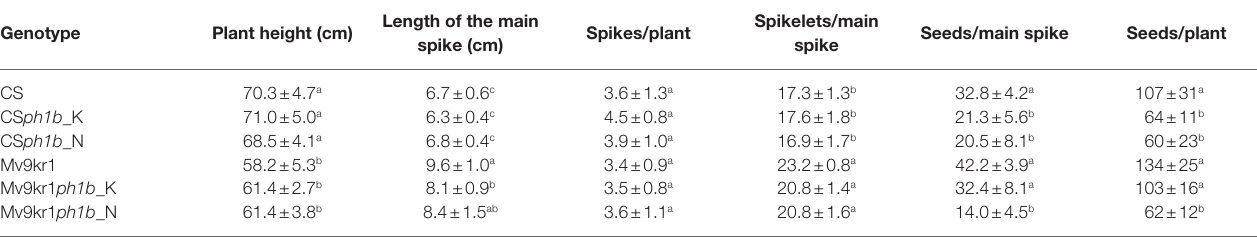
Data represent mean ± standard deviation of 5–10 plants per genotype for each morphological parameter. Different letters indicate significant differences between the genotypes at p < 0.05, using Tukey’s post-hoc test. The plants were grown in a glasshouse during the 2020–2021